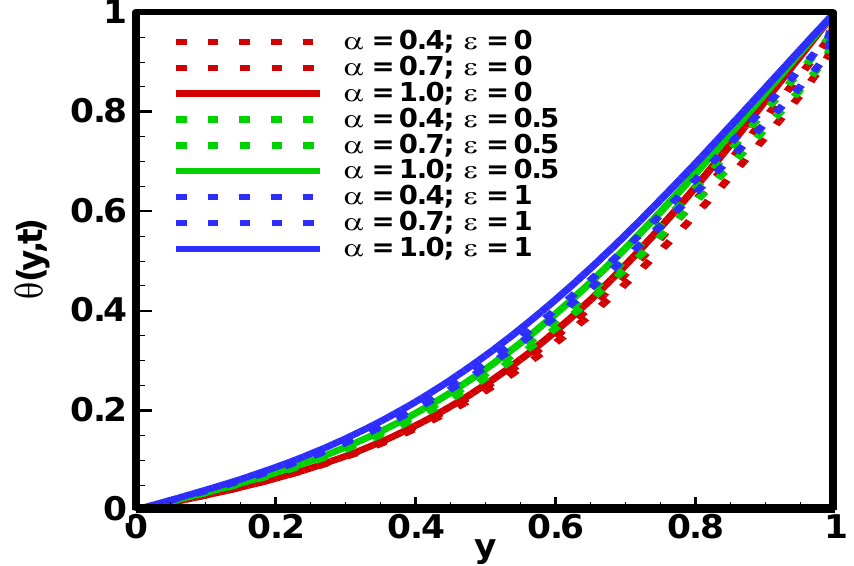
= 0.1, Pr = 21, Q s = 5, and φ = 2𝛽 = 0.1, 𝑃𝑟 = 21, 𝑄 2 = 5, and 𝜙 = 0.1 . 𝑠